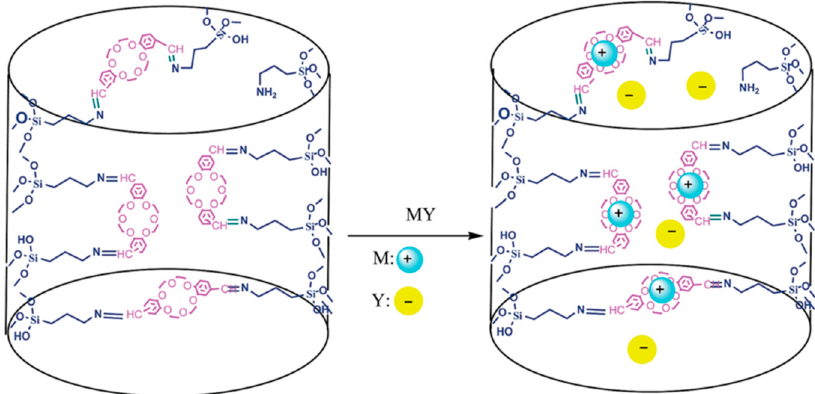
Figure 30 . Operation of catalyst in presence of nucleophile salt. Reproduced with permission from [42].